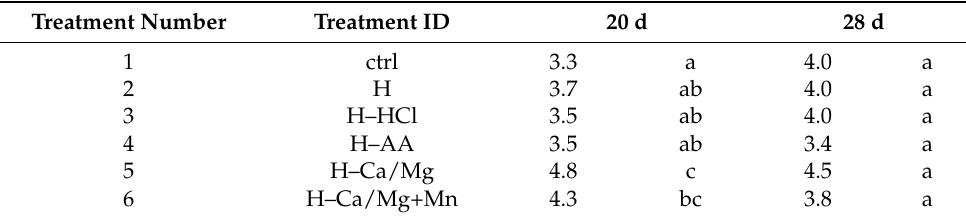
Figure 1. Soybean root and shoot biomass at 32 (growth stage V8+) and 53 d (growth stage R1–R2) after planting for a hydroponic nutrition study. “ctrl” = Hoagland solution; “H” = Hopkins single-nutrient source (SNS) solution; “HCl” and “AA” indicate that pH was adjusted in-season with hydrochloric or acetic acid, respectively; “-Ca/Mg” = reductions of 21% for Ca and 73% for Mg, as compared to the full strength H solution; “+Mn” = 25% increase in concentration compared to full-strength H solution, also adjusted with AA (Table 1). Treatments within a single graph (quadrant) sharing the same letter are not statistically different ( p = 0.05; n = 3). Table 3. Soybean canopy visual ratings (scale of 0 to 5, with 0 = dead and 5 = healthy green) at